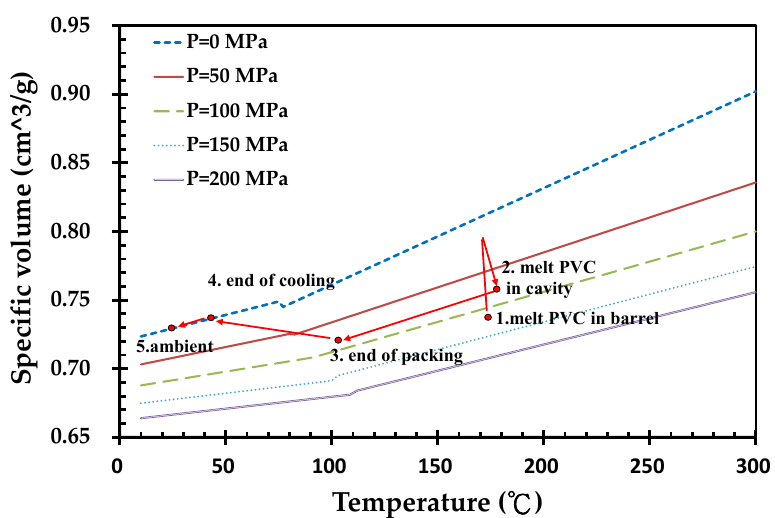
Figure 6. Temperature, pressure and specific volume of PVC during injection molding process.